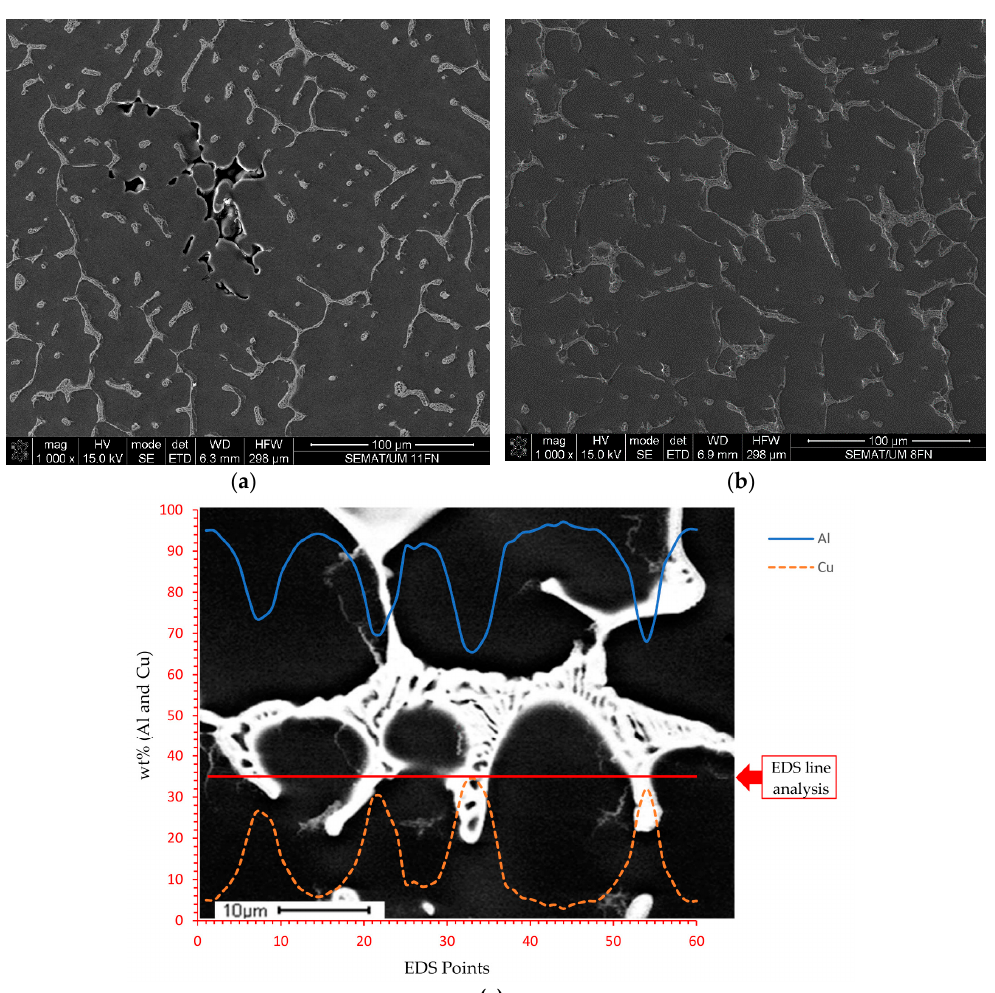
Figure 11. ( a ) Traces of oxides appeared in a defect location, batch 90U. ( b ) EDS quantification of the point in ( a ). Metals 2019 , 9 , x FOR PEER REVIEW